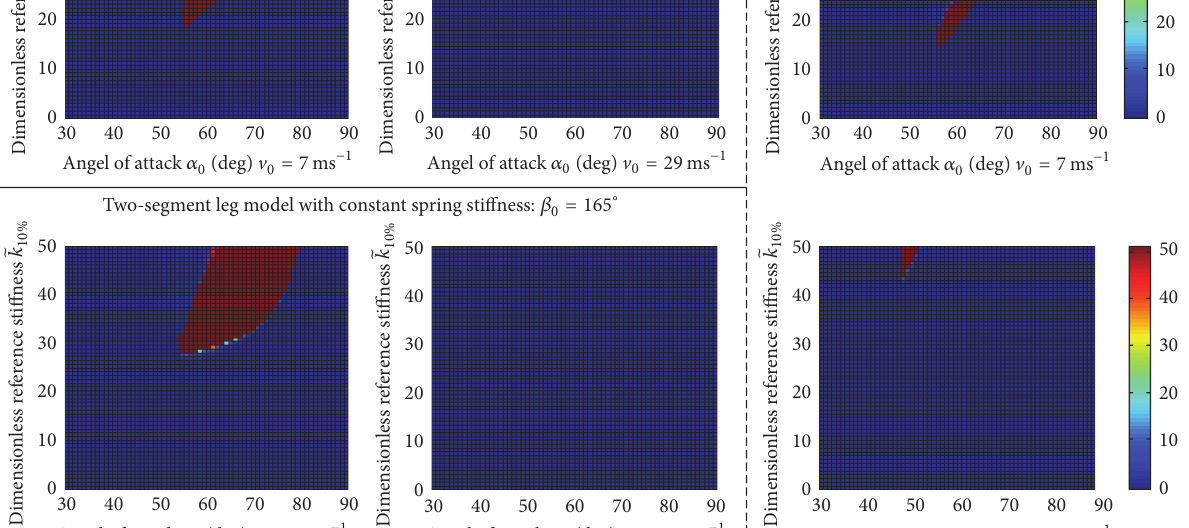
̃ 𝑘 𝛼 10 % and 0 in the two-segment leg model with “J”-curve spring stiffness (the